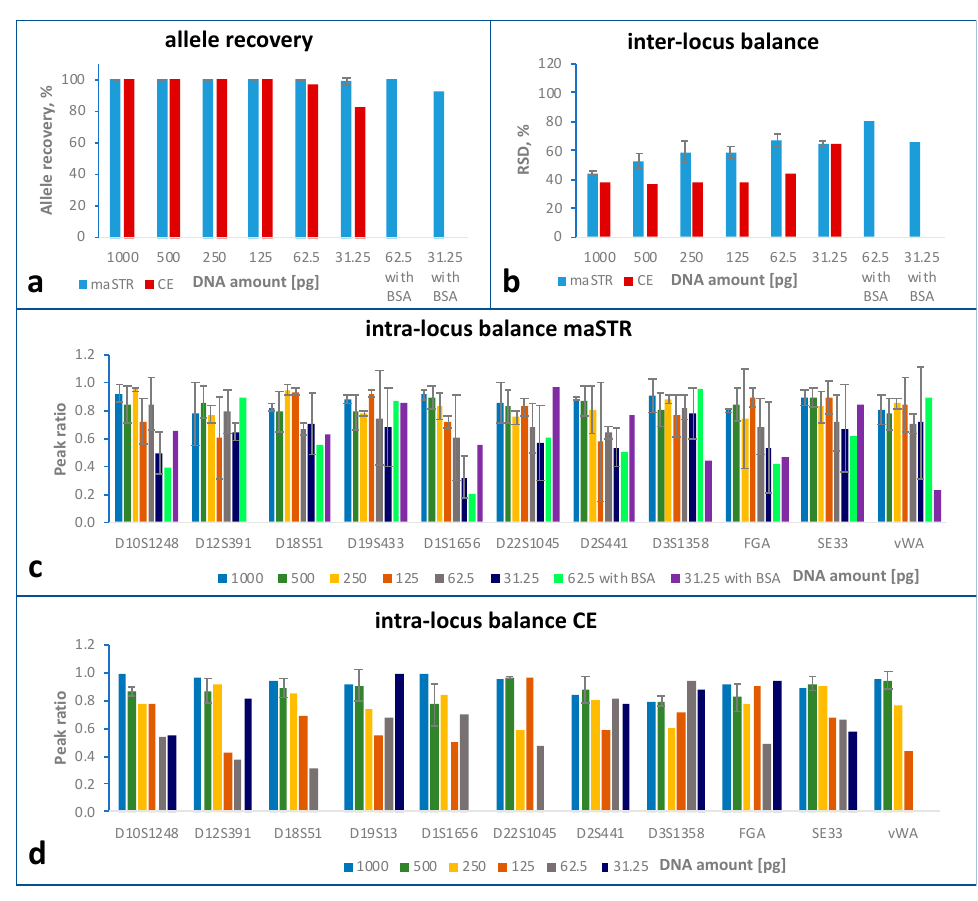
Figure 1. Sensitivity study comparing STR typing using maSTR assay (three or two replicates, see main text) or CE with PowerPlex ESX17 kit (one replicate). Human DNA A5 of the indicated amounts was analysed with the respective assay. For 62.5 pg and 31.25 pg DNA samples, the PCR buffer of the maSTR assay was in addition supplemented with 0.6 µM BSA (one replicate each). Error bars represent standard deviations. ( a ) Comparison of allele recoveries, which are the percentages of correctly called alleles (maSTR assay, blue bars; PowerPlex ESX17, red bars). ( b ) Inter-locus balance, expressed as the relative standard deviation (RSD) of all loci which is calculated by dividing the standard deviation of the reads (or RFUs) obtained per locus by the mean number of reads (or RFUs) per locus (maSTR assay, blue bars; PowerPlex ESX17, red bars). ( c , d ) Intra-locus balance of heterozygous STR loci of DNA A5 analysed with maSTR assay ( c ) or PowerPlex ESX17 ( d ), calculated as the ratio of the peak heights (or of the sequence read numbers for maSTR assays) of the allele with the lower RFU value (or lower number of reads) by the peak of the allele with the higher RFU value (or higher number of reads). The different DNA amounts are indicated by the different colours.